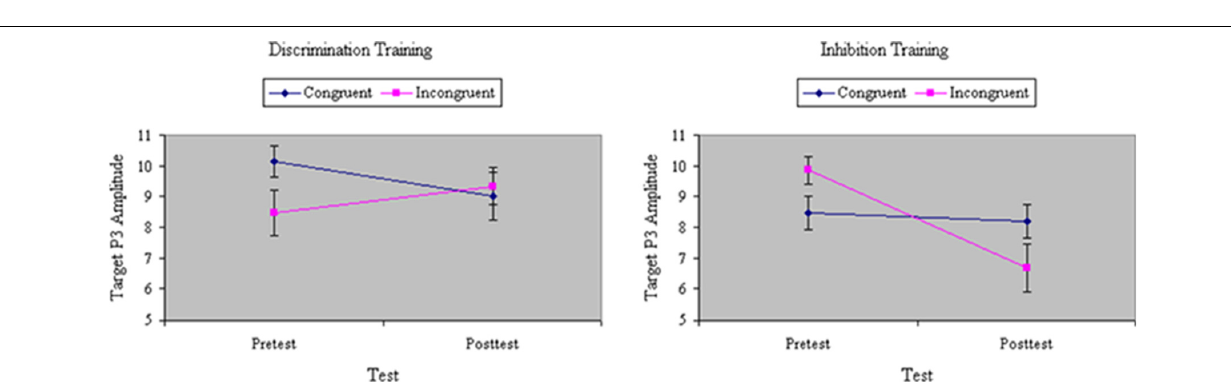
p < 0.001, MS e = 33.12, η 2 = 0.19. As can be seen in Figure 8